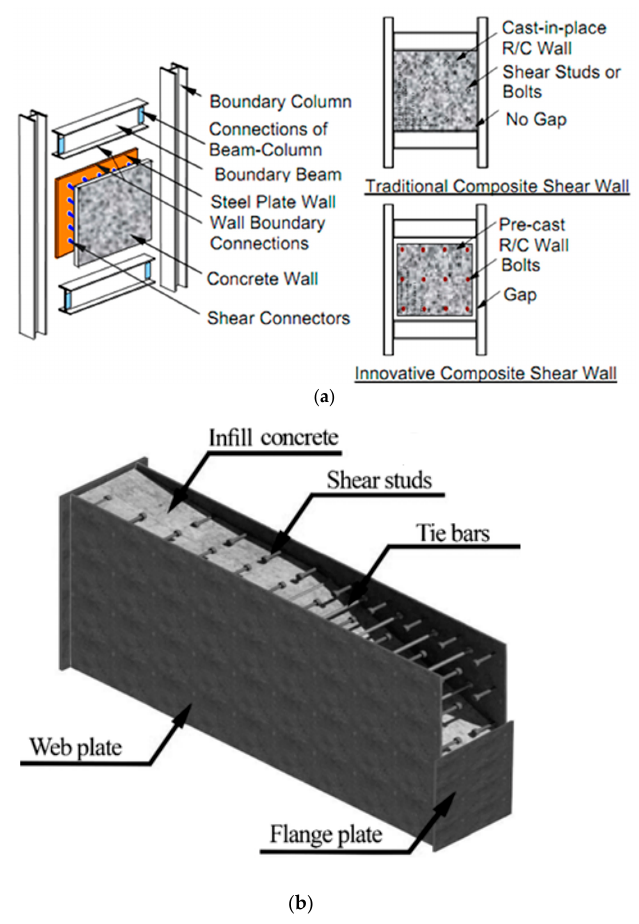
Figure 1. Traditional and innovative composite steel plate shear wall: ( a ) all compounds of the composite shear wall, ( b ) cross-section of composite shear wall.